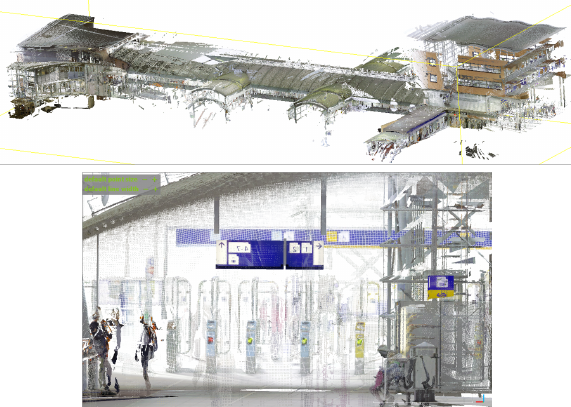
Figure 1. Top: overview of the whole points of Amersfoort station; bottom: sample of point clouds data inside the station.